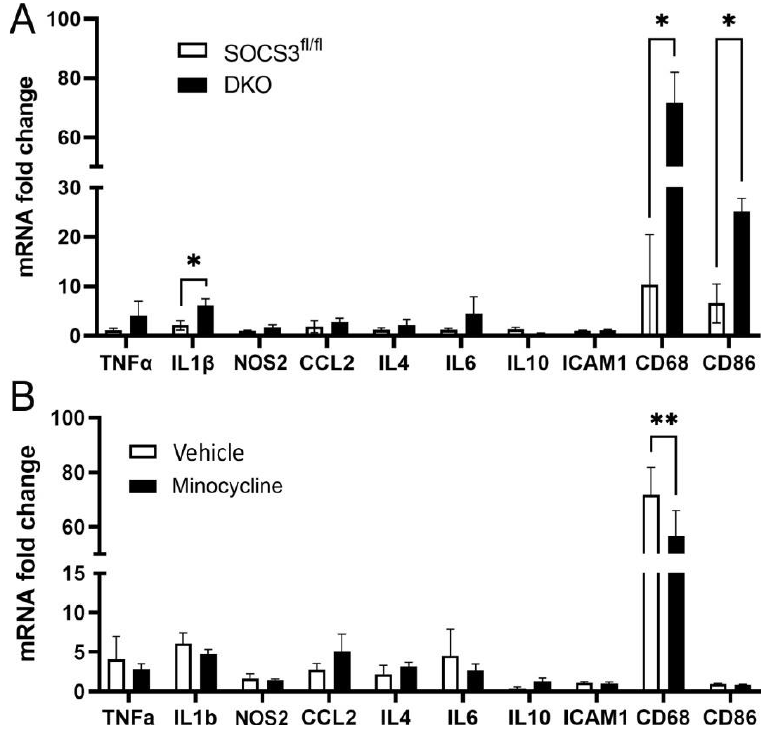
Figure 6. The effect of minocycline in retinal immune related gene expression. The mRNA was ex- tracted from 9-month-old wild type ( Socs3 fl/fl ) or DKO mouse retinas ( A ) or vehicle- and minocycline- treated DKO (9-month old) retinas ( B ). The expression of inflammatory genes including Tnfa , IL1b , Nos2 , Ccl2 , Il4 , Il6 , IL10 , Icam1 , Cd68 , and Cd86 was evaluated by real-time RT-PCR. Mean ± SEM, n = 6. * p < 0.05, ** p < 0.01 by Student’s t -test.